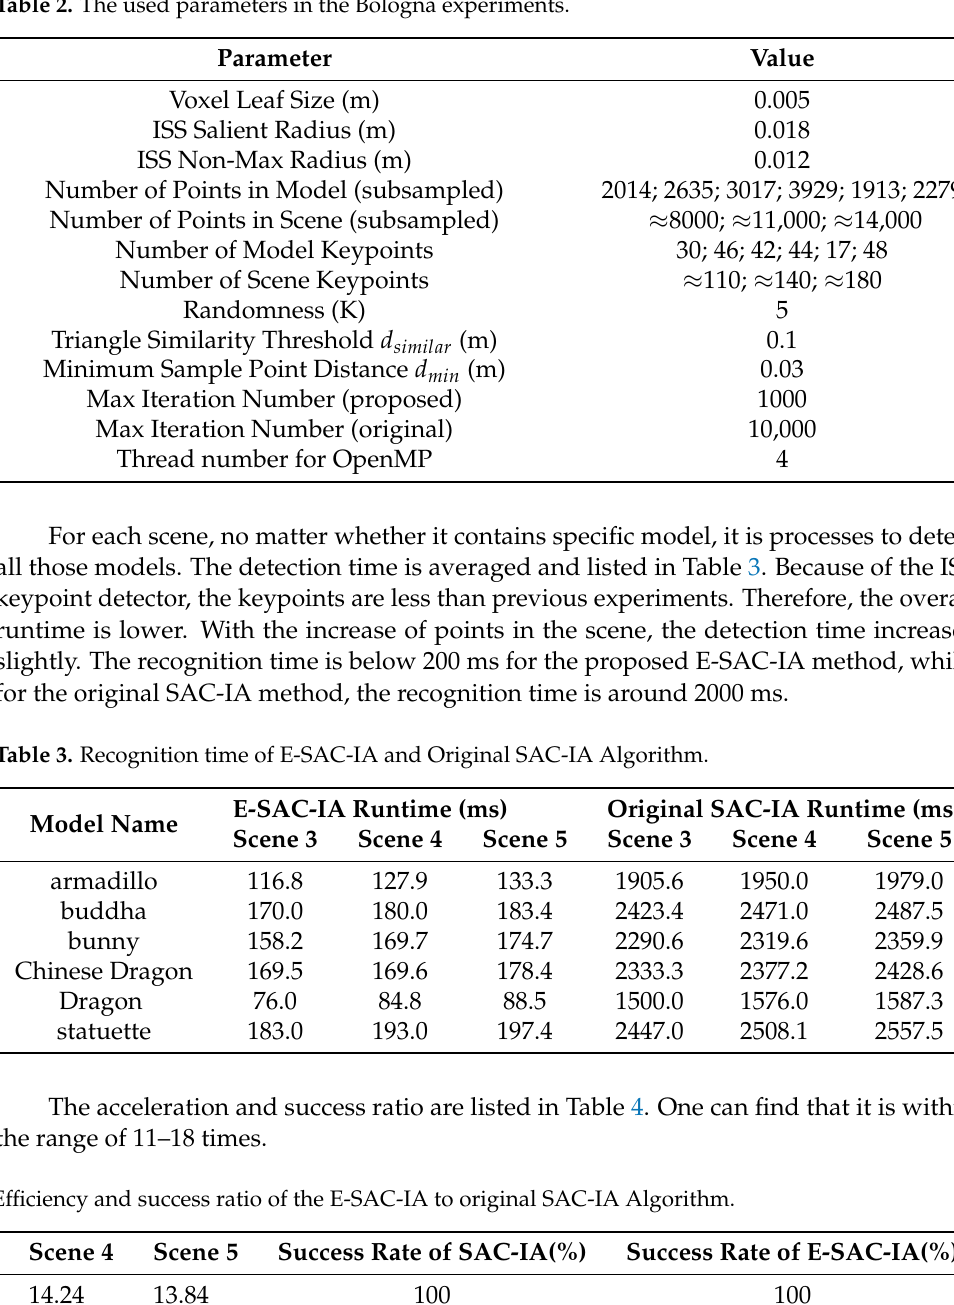
Table 2. The used parameters in the Bologna experiments.